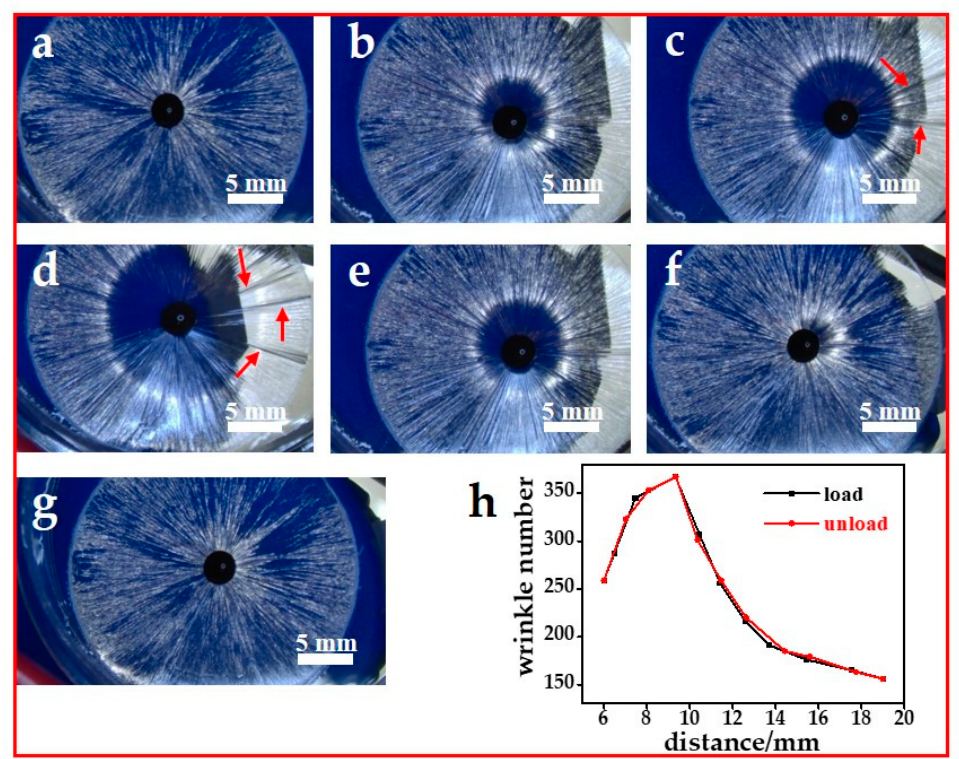
Figure 2. Optical microscopy images of surface morphologies of the floating PS film with a 4 μ L magnetic droplet on it. The PS film is 100 nm thick, and the distance between the magnet and the magnetic droplet is ( a ) 19 mm, ( b ) 9.336 mm, ( c ) 7.457 mm, ( d ) 6 mm, ( e ) 8.524 mm, ( f ) 11.409 mm, and ( g ) 19 mm, respectively. ( h ) The relationship of the wrinkle number versus the distance between the magnet and the magnetic droplet in the dynamic and reversible process of loading and unloading the magnetic field.